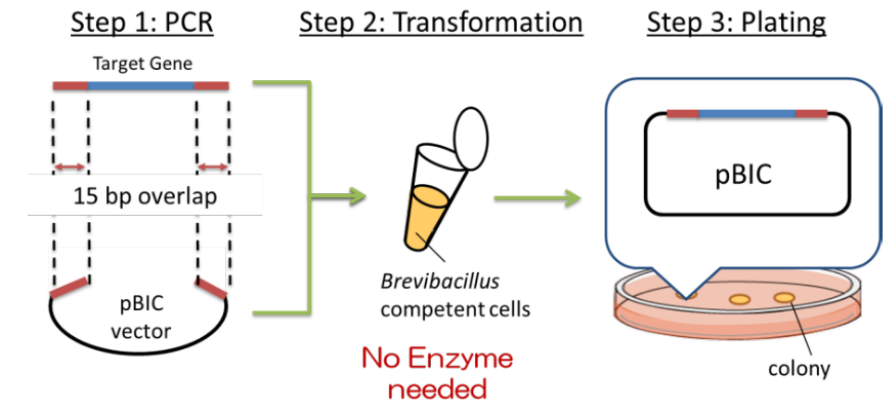
Figure 2. Summary of BIC ( Brevibacillus in vivo cloning)